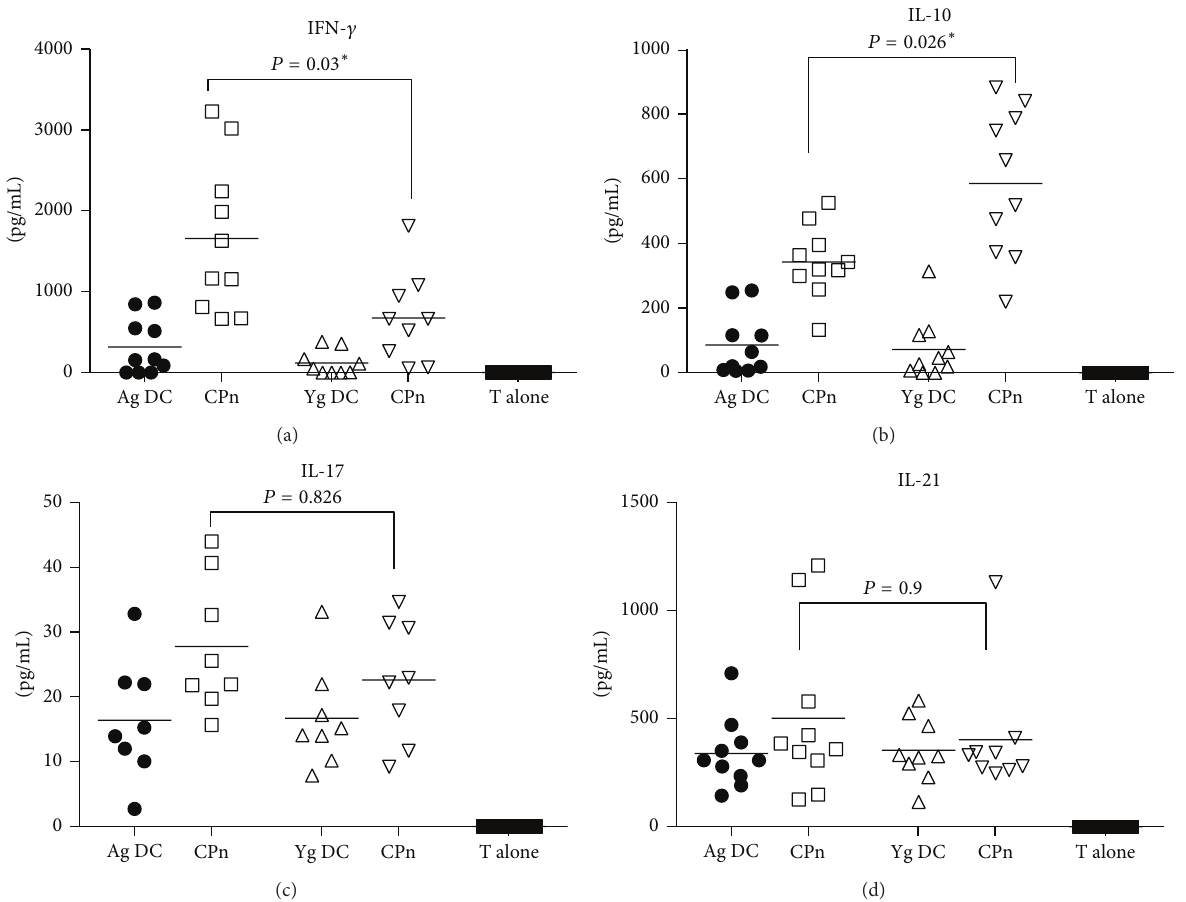
Figure 5: Effect of CPn-stimulated DCs from aged and young donors on T cell cytokine induction. Graphs depict the level of cytokines secreted by T cells after 6 days in an allogeneic coculture with CPn-stimulated DCs from aged and young subjects. (a) IFN- 𝛾 ; (b) IL-10; (c) IL-17; (d) IL-21. Each dot corresponds to a separate subject. Data is of 10 aged and 10 young subjects. 𝑃 value depicted is comparison of CPn-stimulated DCs T cell from aged subjects with their young